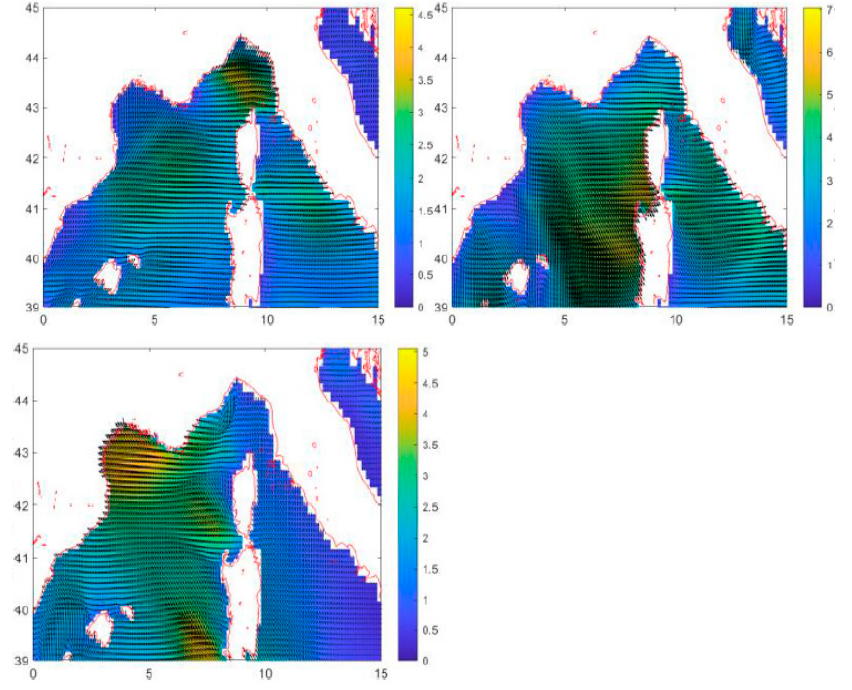
Figure 2. December–January–February. Source: Ship weather routing software output, Authors (2020).